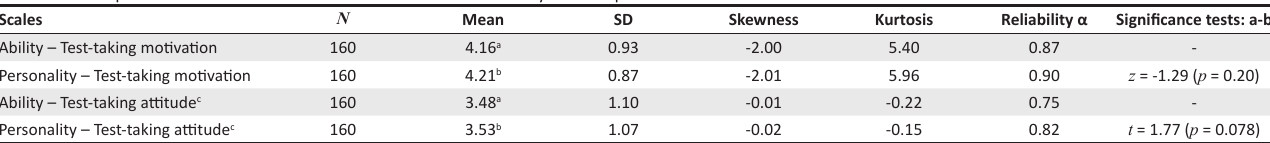
TABLE 3: Descriptive and Wilcoxon’s statistics of the Test Attitude Survey – an adapted version of the measure. Scales